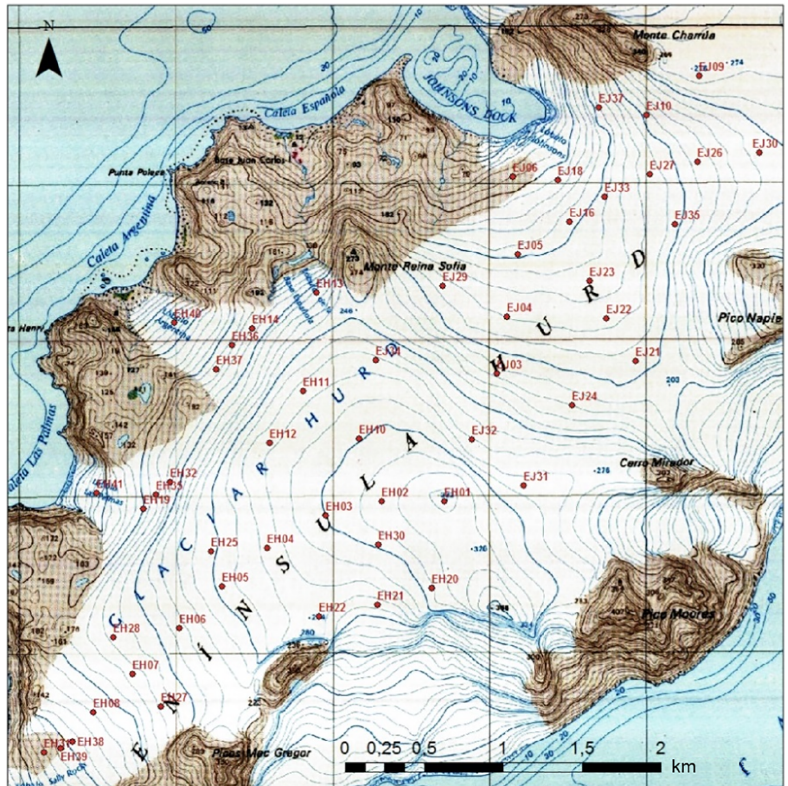
Figure 2. Network of stakes on Hurd and Johnsons glaciers at the end of the 2012–2013 Antarctic summer campaign. (Base map: SGE,